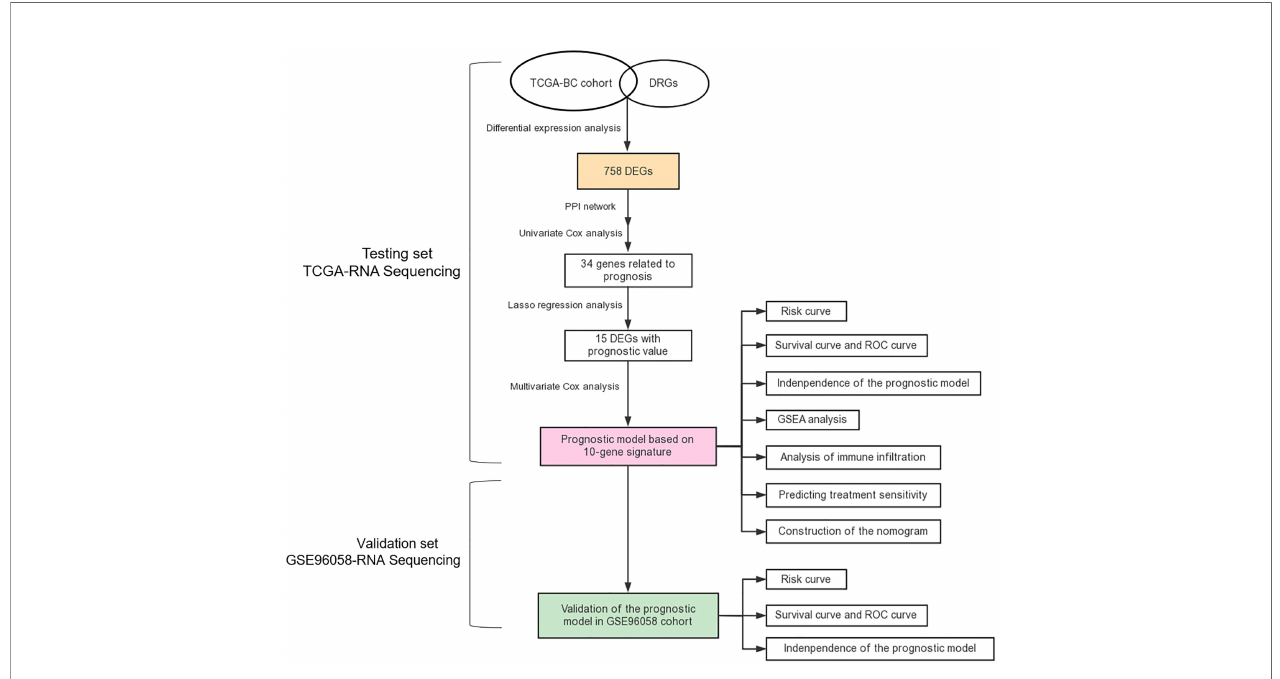
FIGURE 1 | Flow chart of this